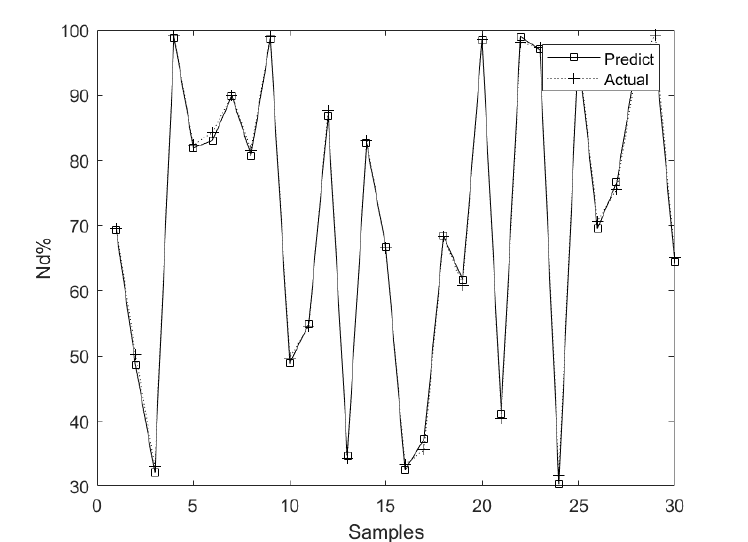
Figure 4. Prediction model result of wavelet neural network.